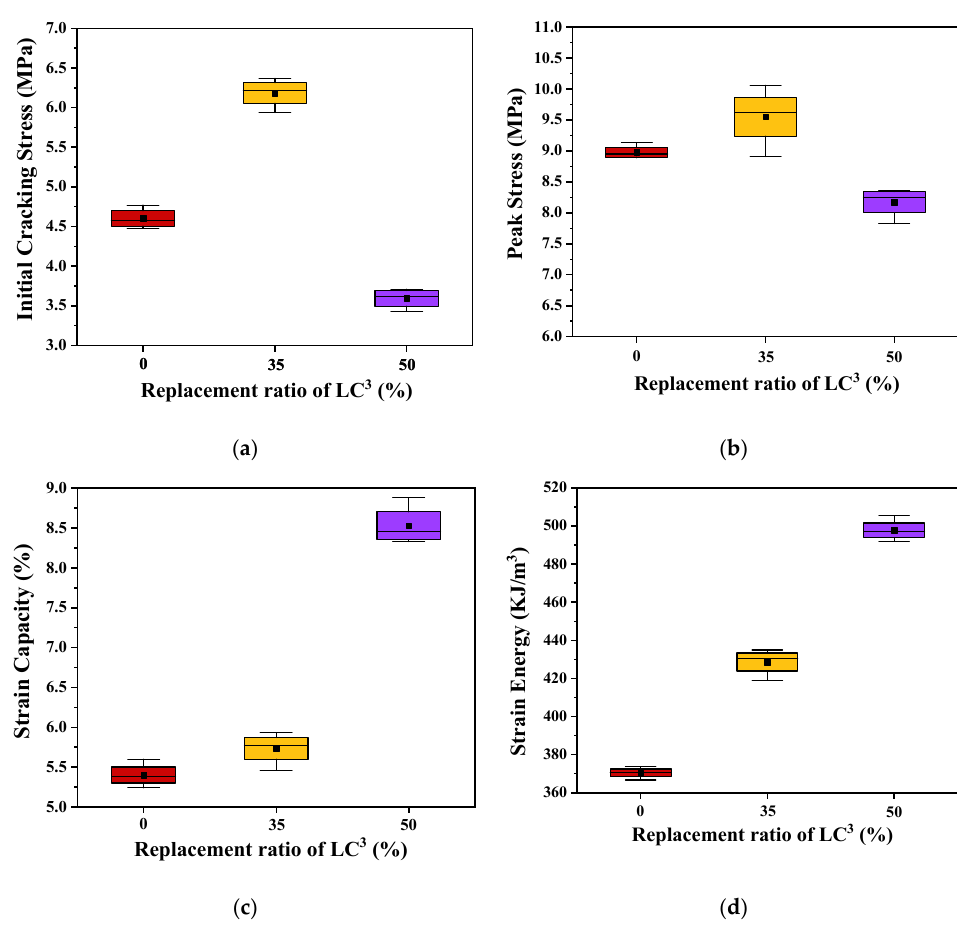
Figure 12. Characteristic parameters of the three types of ECC: ( a ) initial cracking stress; ( b ) peak stress; ( c ) strain capacity; ( d ) strain energy.